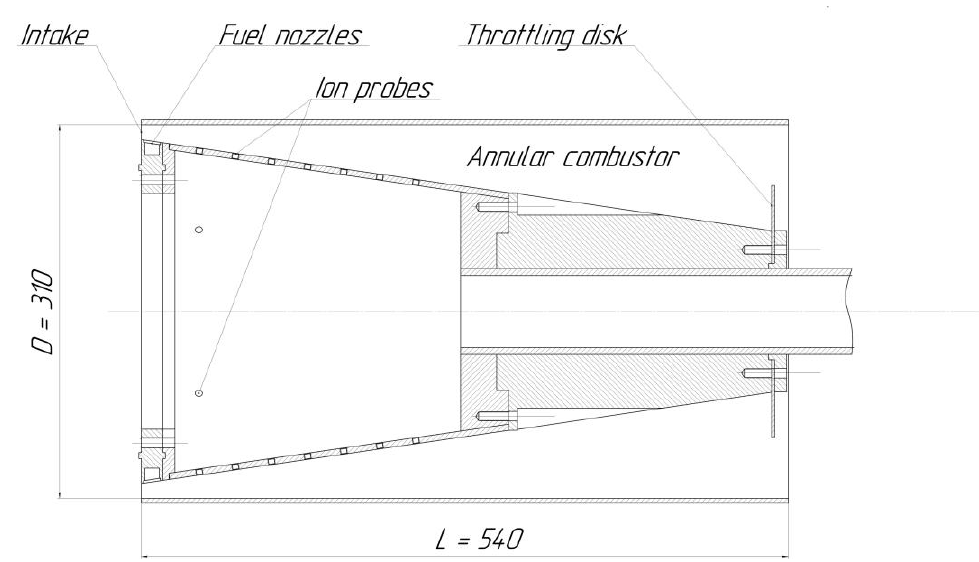
Figure 15. Schematic of the RDE.